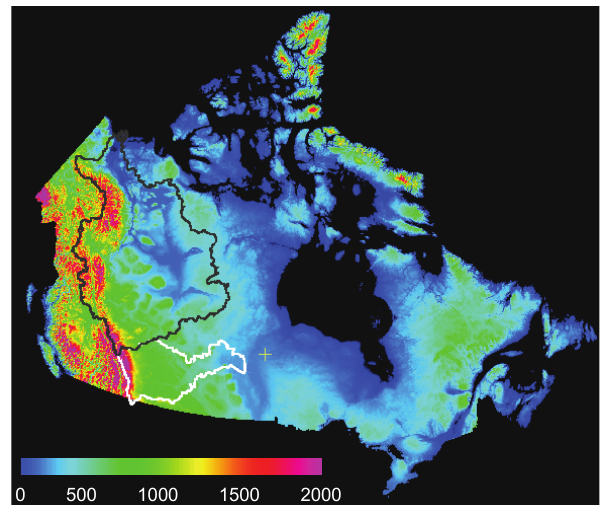
Fig. 5. Terrain elevation (meters above sea level) of Canada’s land- mass generated by combining three datasets of CDED, SRTM and GTOPO3 (see Sect. 2.2.4 for details). The two polygons represent the Mackenzie River basin (MRB, delineated by the black line) and the Saskatchewan River basin (SRB, delineated by the white